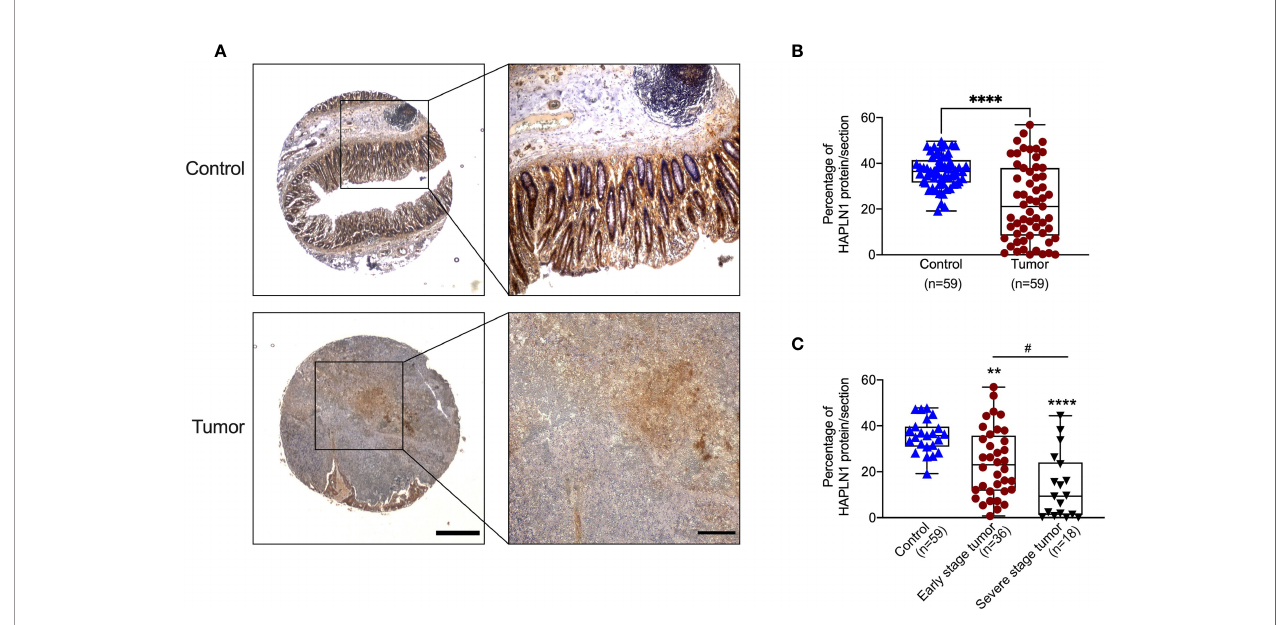
FIGURE 2 | Colorectal cancer (CRC) patients have decreased HAPLN1 protein in tumors. (A) Colontissues were collected from tumors and normal tissue adjacent to the tumor from CRC patients ( n = 59). Tissues were sectionedandstained with HAPLN1 antibodyby immunohistochemistry(low magni fi cation scalebar = 200 m m; high magni fi cationscale bar = 50 m m). (B) The area of HAPLN1 staining in all stages of CRC patients was normalizedto the total area of the colonsection. (C) The area of HAPLN1 staining inearly (stages I and II, n = 36) and severe stages (stages III and IV, n = 18) of CRC patients was normalized to the total area of the colon section. Results are mean± SEM. ** P < 0.01, **** P < 0.0001 compared with a normal tissue adjacent to the tumors from CPC patients. # P < 0.05 compared with early stage tumour of CPC